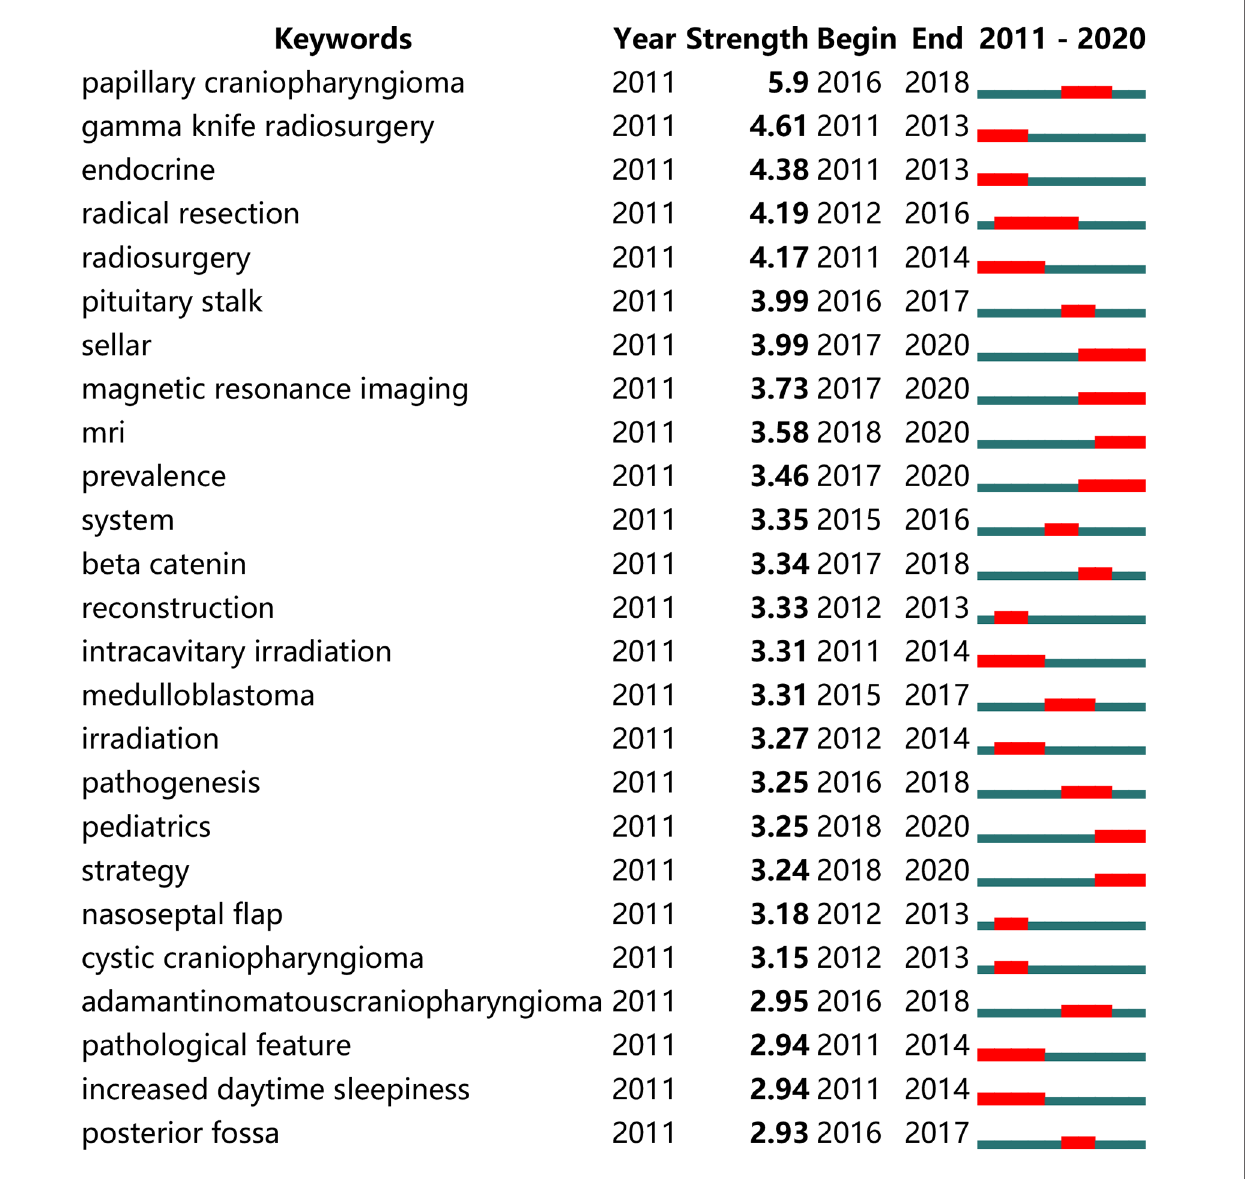
FIGURE 5 | The top 25 terms with the strongest citation bursts during 2011 to 2020. Conducted by CiteSpace (version 5.7.R3, Drexel